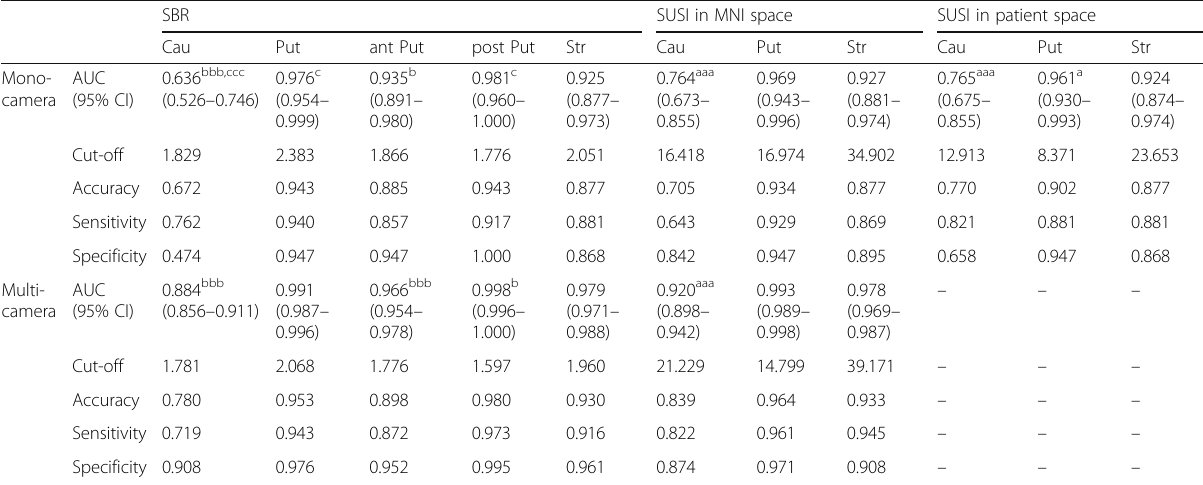
Table 1 Area (AUC) under the ROC curve, cut-off (based on Youden ’ s criterion), and resulting total accuracy, sensitivity, and specificity for identification of neurodegenerative etiology of parkinsonism (mono-site/mono-camera setting) or PD (multi-site/multi- camera setting). (Cau = caudate, Put = putamen, Str = striatum, ant = anterior, post = posterior) SBR SUSI in MNI space Cau Put ant Put post Put Str Cau Put Str Cau Put Str Mono- AUC camera (95% CI)